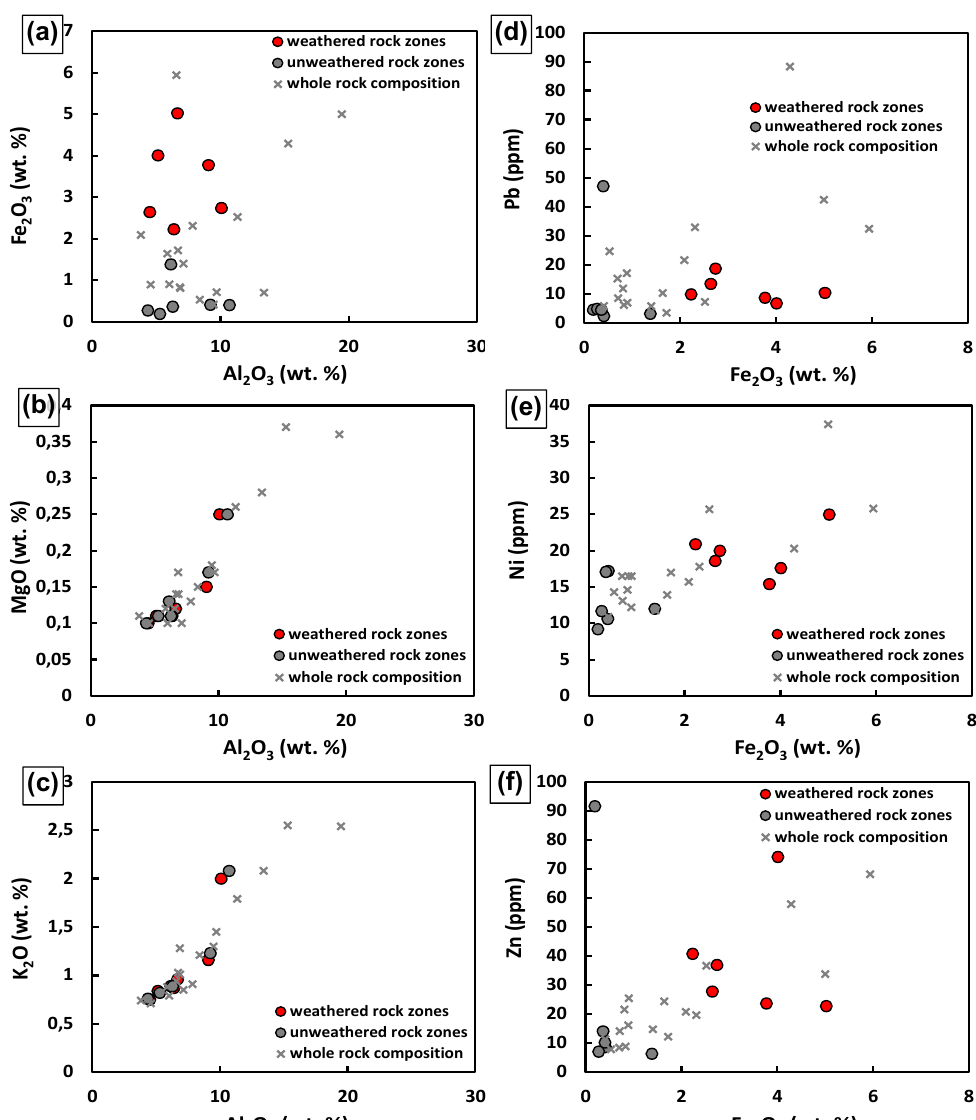
Figure 9. Elemental composition of analyzed rock samples. Potassium and magnesium do not vary between weathered and unweathered zones, indicating low influence of water–rock interaction on aluminosilicate dissolution. Correlation of Zn, Pb and Ni indicates coprecipitation/sorption with secondary iron (oxide ‐ ) hydroxides.